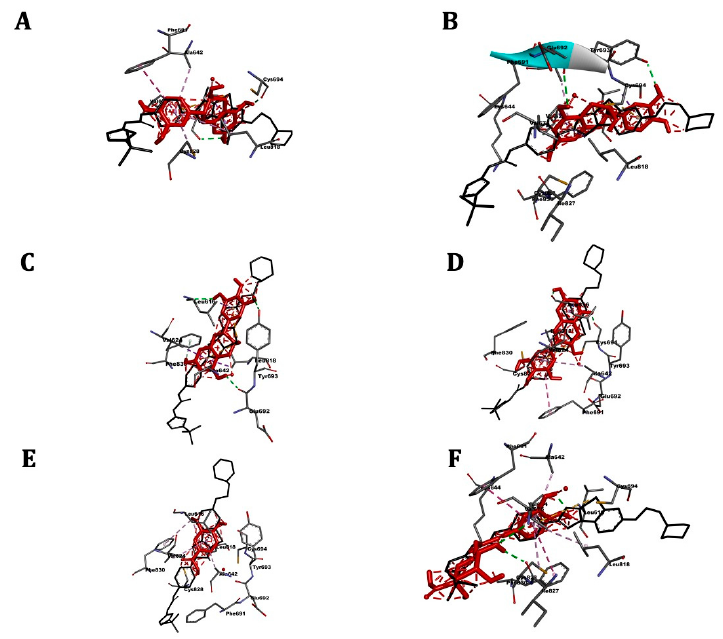
Figure 7. 3D scheme of the ligand–FLT3 receptor interactions. In red, tested molecule ( A ) catechin, ( B ) epicatechin, ( C ) epigallocatechin, ( D ) gallocatechin, ( E ) vanillic acid, ( F ) chlorogenic acid; in black, reference molecule (quizartinib) and labeled amino acid residues interacting with the tested molecule.